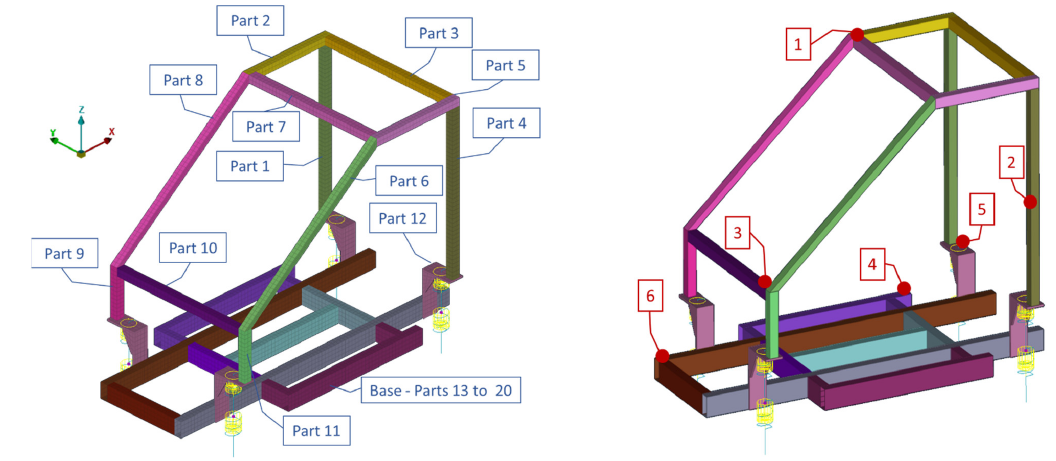
Figure 5. Parts of the FE model ( right ) and acceleration measurement locations ( left ). At the current application, all three axes of acceleration measurement are taken into account, thus the complete Transmittance Function table is calculated, based on Equation (12), keeping active all the parameters of the damage-detection framework.